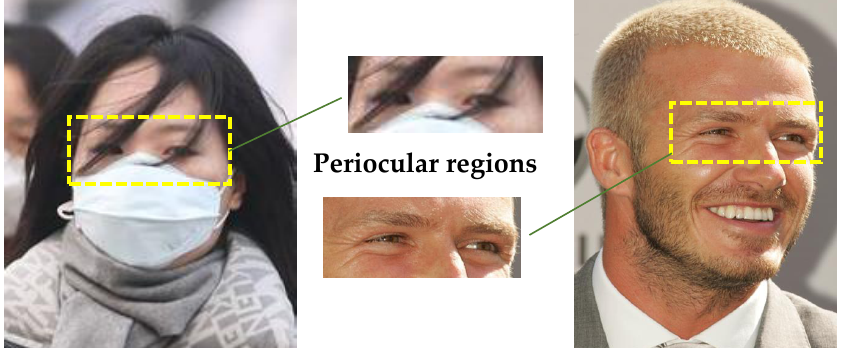
Figure 1. Samples of periocular regions. We demonstrate sample images of the periocular region that including eyebrows. The images are collected from The Korea Times [10] and Kitchen Decor